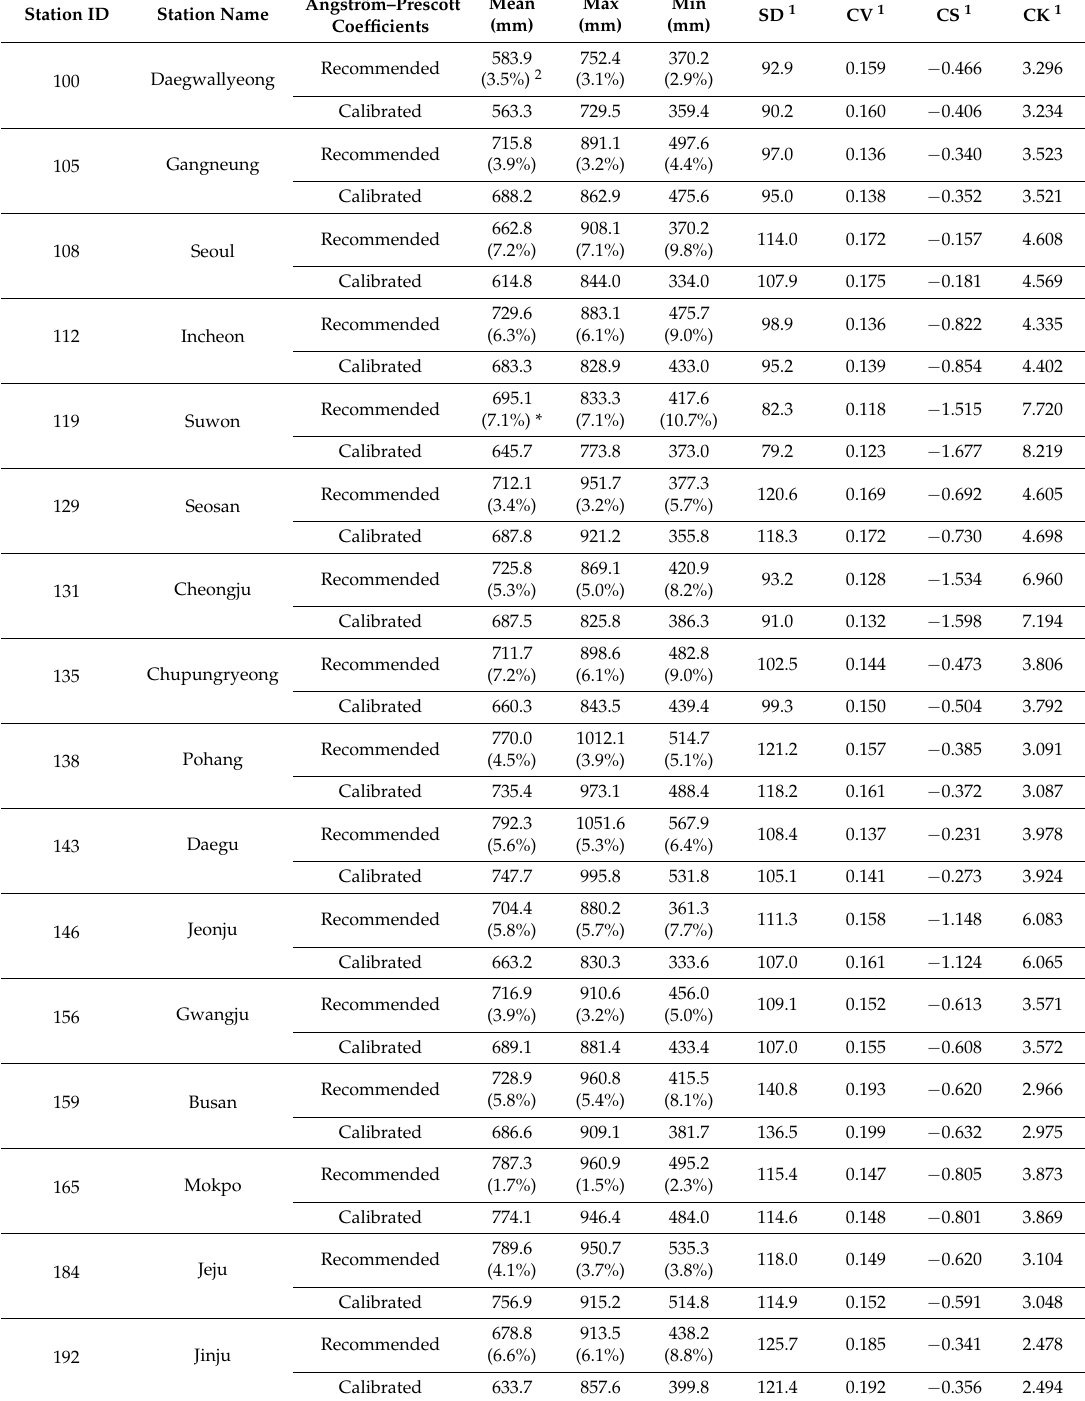
Table 3. Basic statistics of the irrigation water requirements (IWRs) for the study sites over a 25-year period